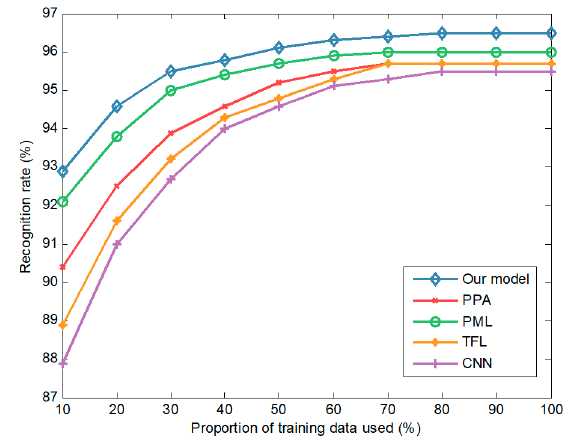
Figure 8. The recognition rates of different methods at a depression angle of 30°.